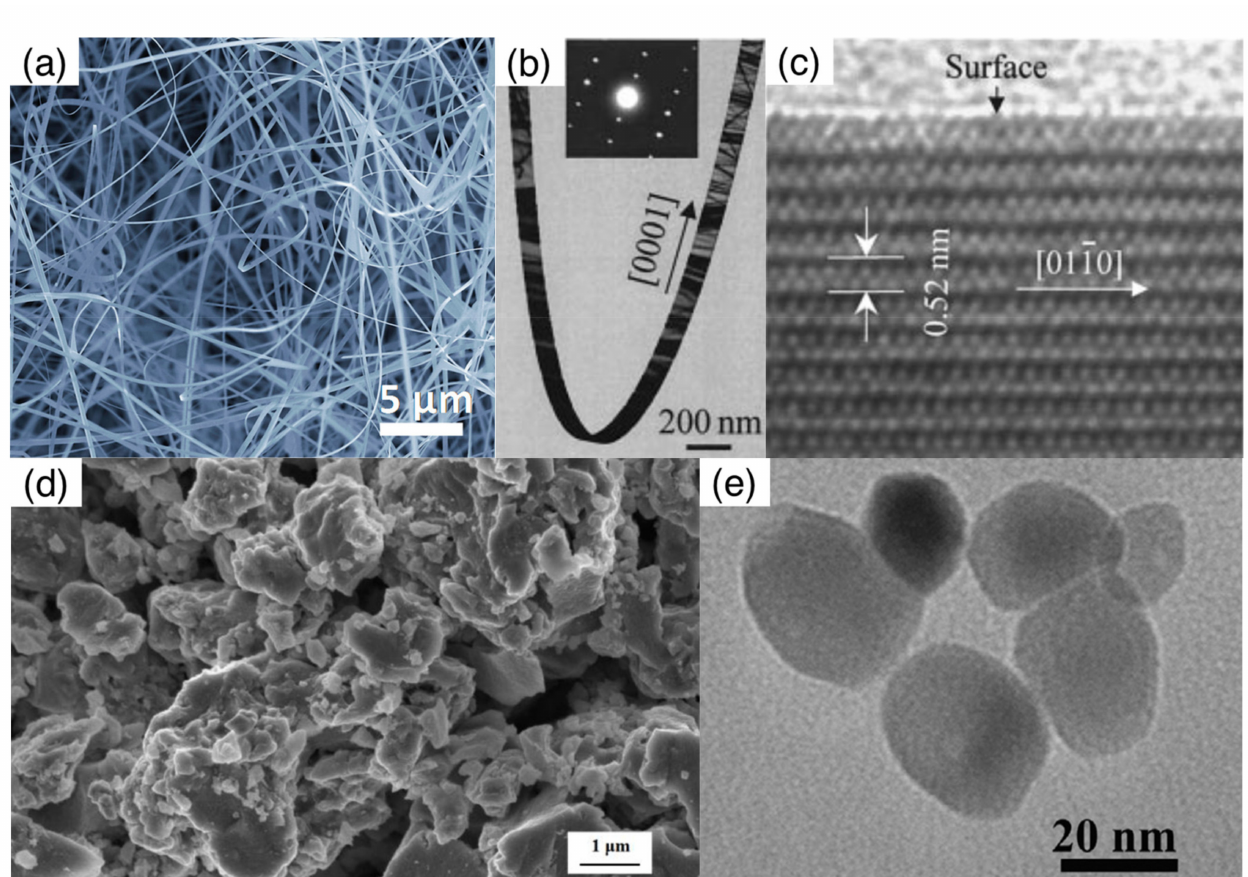
Figure 1. Comparison between the morphological features of nanowires and nanoparticles: ( a ) Scan- ning electron microscopy (SEM) picture of SnO 2 nanowires/nanobelts; ( b ) transmission electron microscopy (TEM) image of a single ZnO nanobelt, the inset reports the selected area electron diffrac- tion (SAED) pattern of the nanobelt; ( c ) high-resolution TEM (HR-TEM) image of the surface of a ZnO nanowire; ( d ) SEM image of a network of SnO 2 nanoparticles; ( e ) TEM image of a few In 2 O 3 nanoparticles. Figure 1a is reprinted from [12]. Figure 1b,c are from [1], reprinted with permission from AAAS. Figure 1d is reprinted from [13]. Figure 1e is reprinted from [14], Copyright (2016),